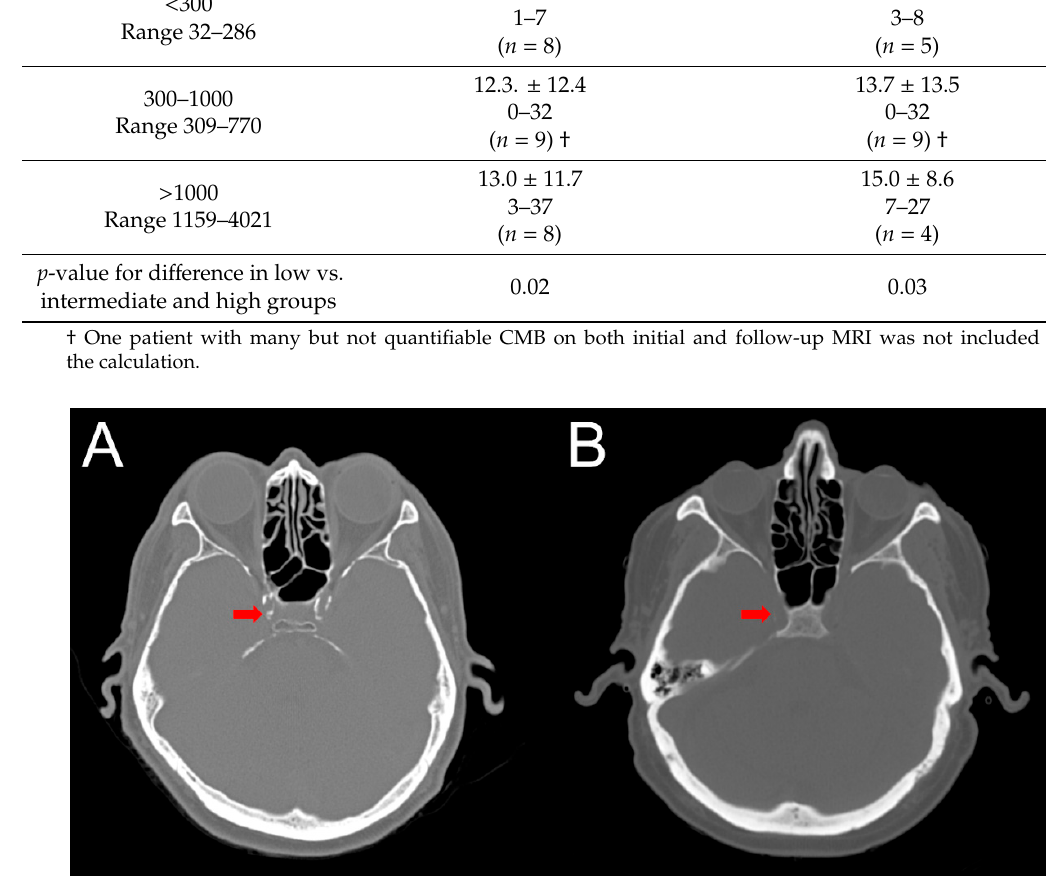
Figure 2. Axial non-contrast head computed tomography (CT) scans comparing patients with a high and low burden of calcification. Head CT obtained from a patient with a “high” burden of calcification ( A ) within the cavernous carotid (denoted by the arrow), which measured 3093 cm 3 . For comparison, axial non-contrast head CT of a patient with a “low” burden of calcification ( B ) within the cavernous carotid, which measured 106 cm 3 .